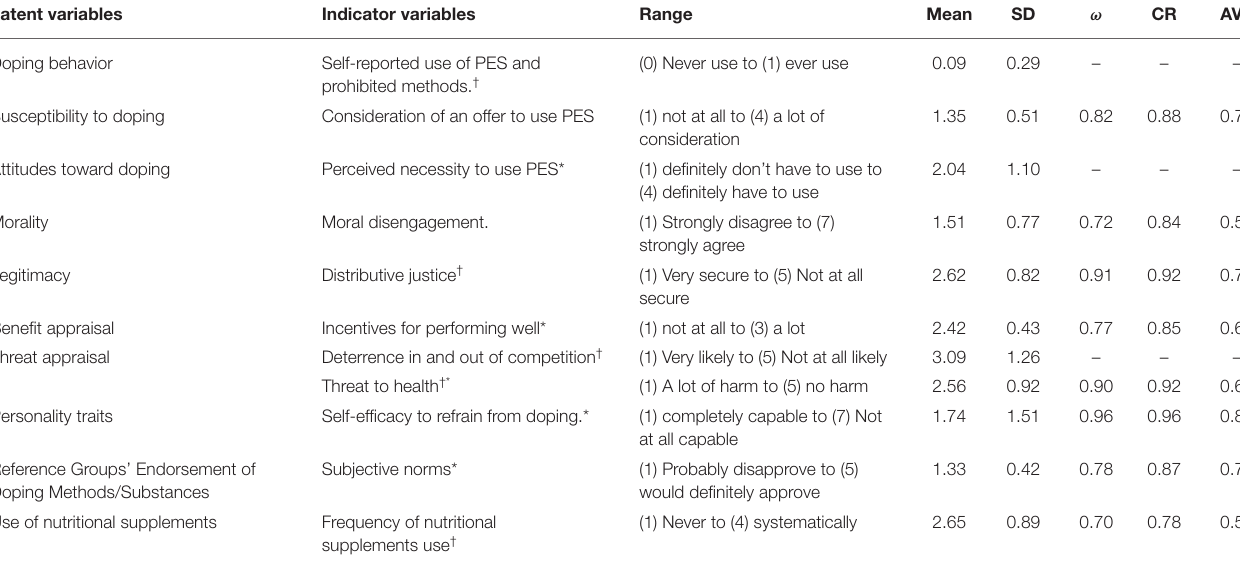
TABLE 2 | Variables, descriptive statistics and internal reliability estimates for the variables measuring the sport drug control model through structural equation